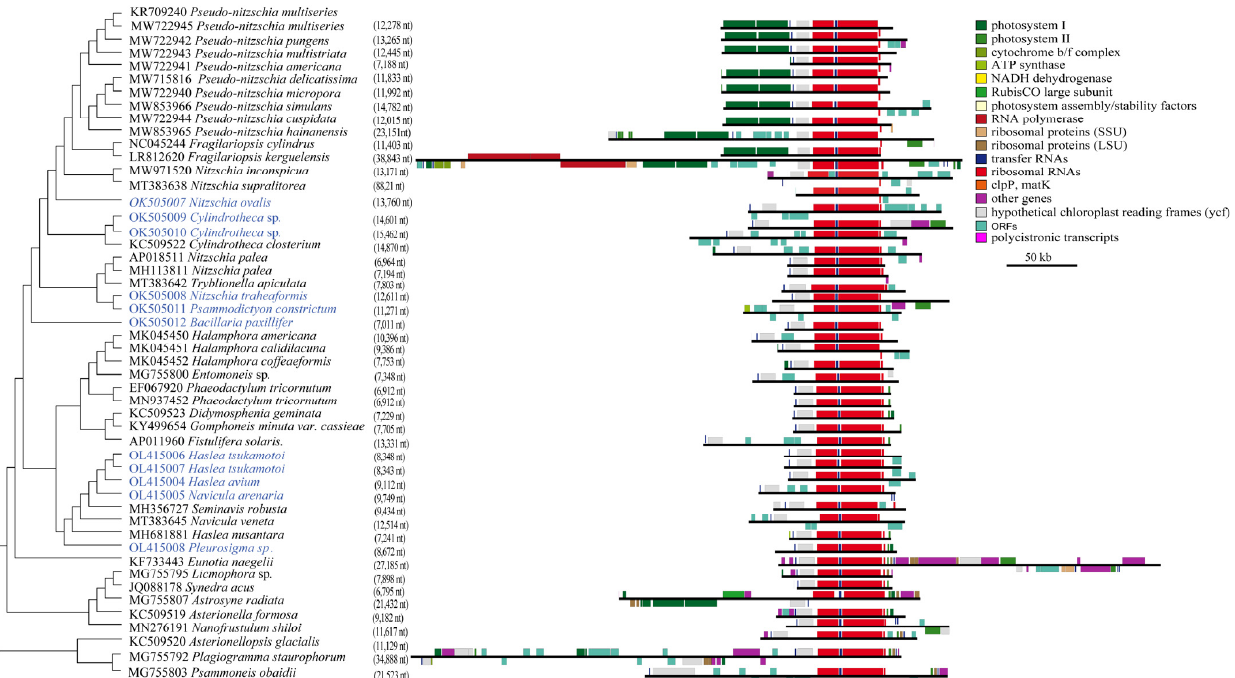
Figure 4. Size variations of the inverted repeated region across cpDNAs of Bacillariophyceae. Colored boxes circumscribe genes in various functional categories, with those above the line transcribed on the forward strand and vice versa for genes below the line.